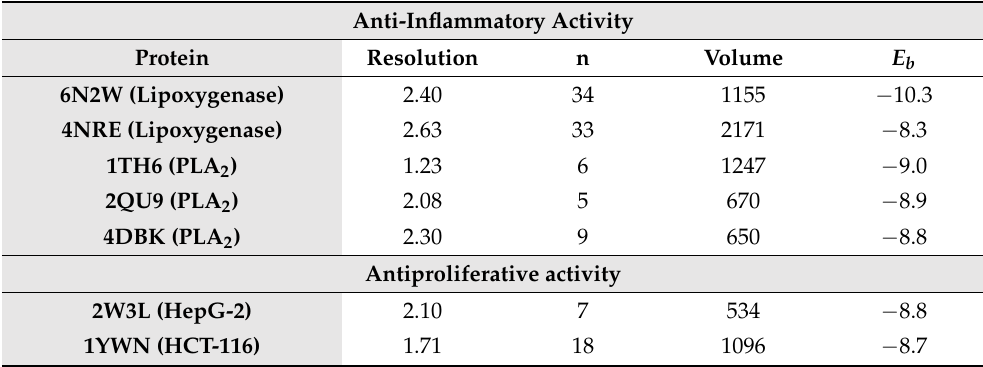
Table 14. Resolution of the crystal structures of the studied proteins in (Å), computed number of 3 detected cavities, best protein cavity volume in (Å ) and the predicted binding free energy of the interaction between the inhibitor and the protein ( E b ) in (kcal · mol − 1